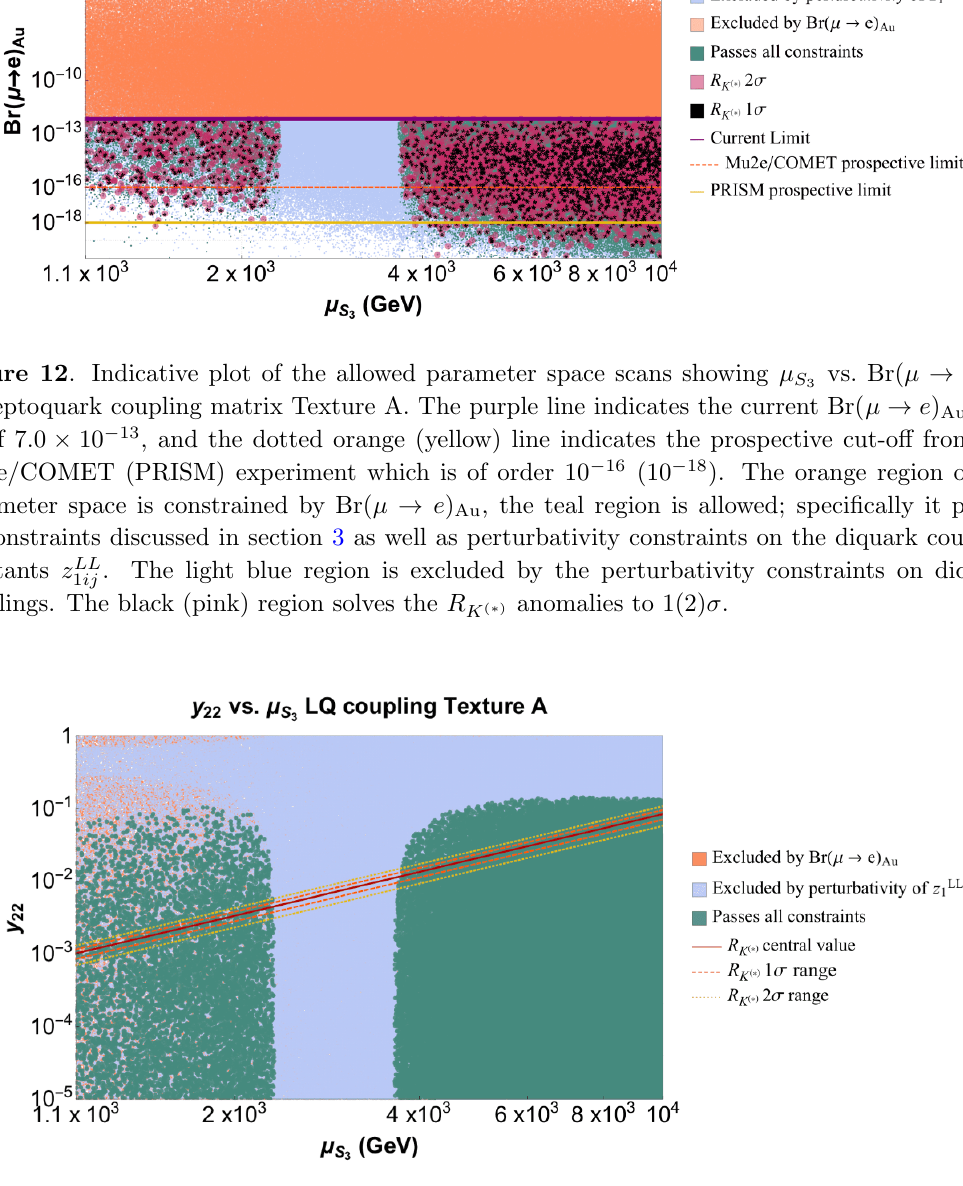
plane, for leptoquark 3 K ( (cid:3) )